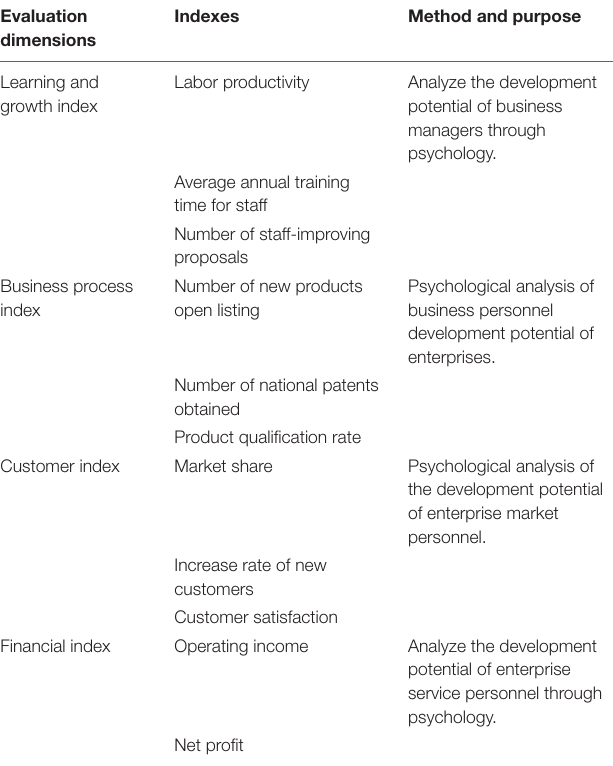
TABLE 2 | Evaluation indexes of